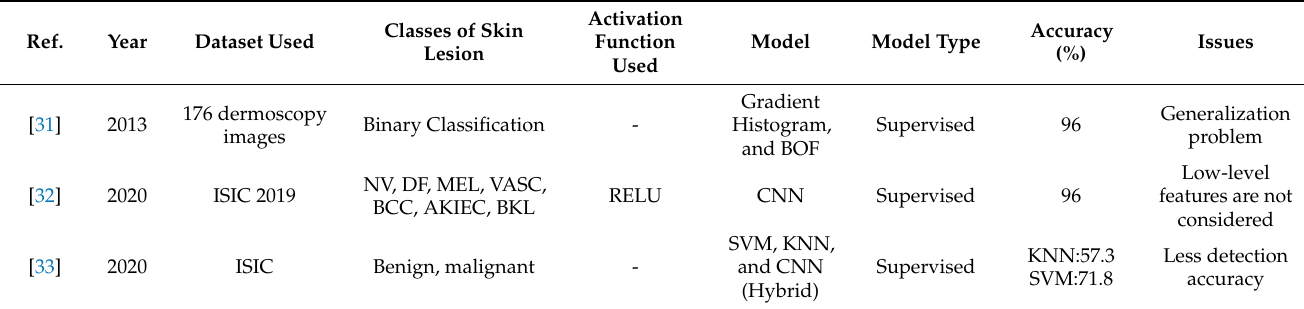
Table 1. Summary of some existing techniques with their